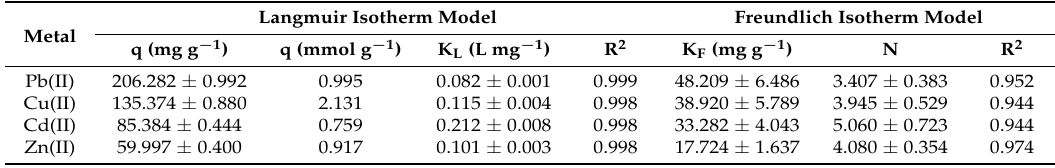
Figure 9. Langmuir and Freundlich adsorption models fits of Pb(II), Cu(II), Cd(II) and Zn(II) on SiTF5PP . Table 5. Adsorption isotherm parameters of metal cations onto SiTF 5 PP .